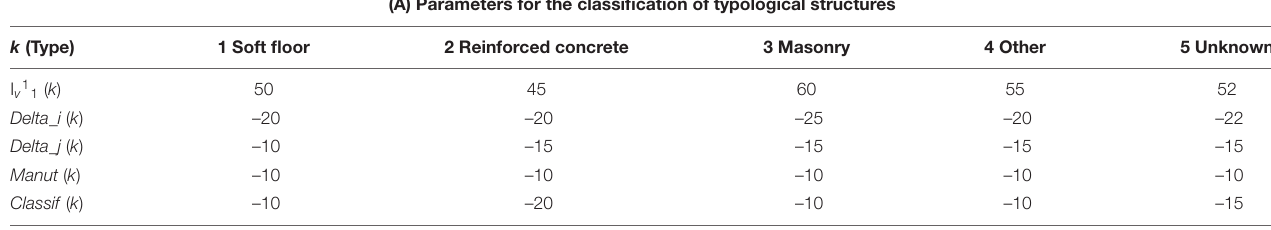
TABLE 2 | Elements for the vulnerability assessment method based on the 1991 ISTAT